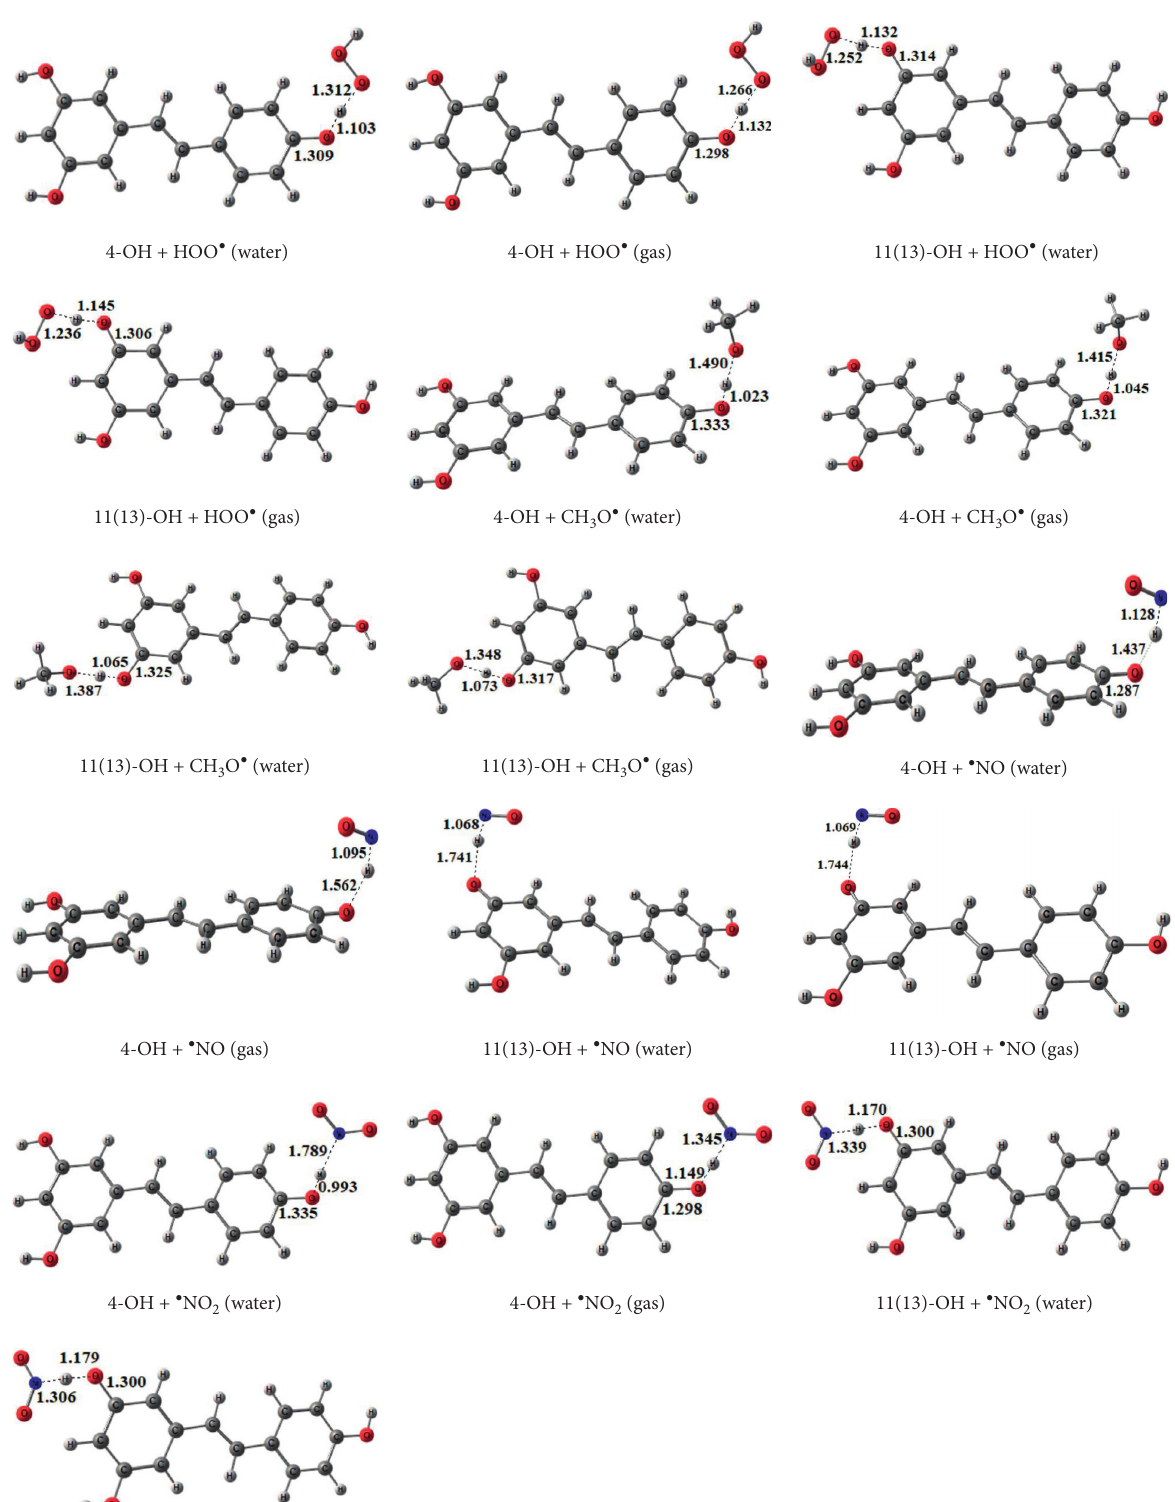
2 radicals attack hydroxy groups of RSV at B3LYP/6-